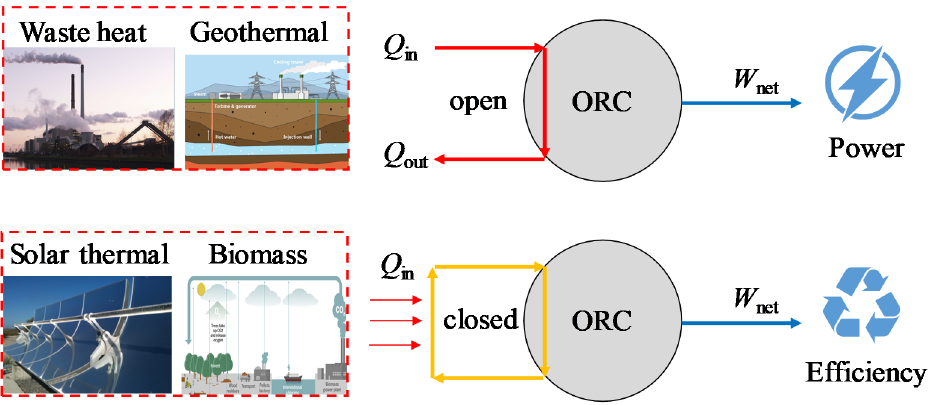
Figure 3. Selection of thermodynamic criteria for different heat sources cases.